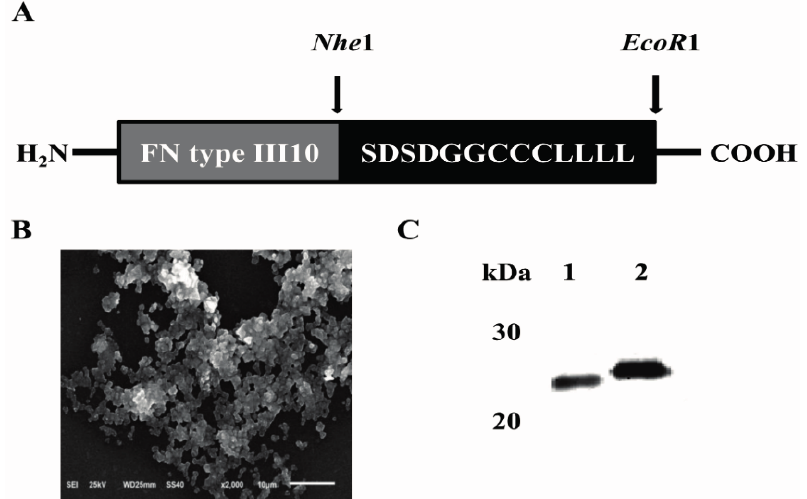
Figure 1. Structure ( A ), SEM image ( B ) and molecular weight ( C ) of FNIII10-PA. Peptide amphiphile sequence (PA), LLLLLLCCCGGDS (L, leucine; C, cysteine; G,